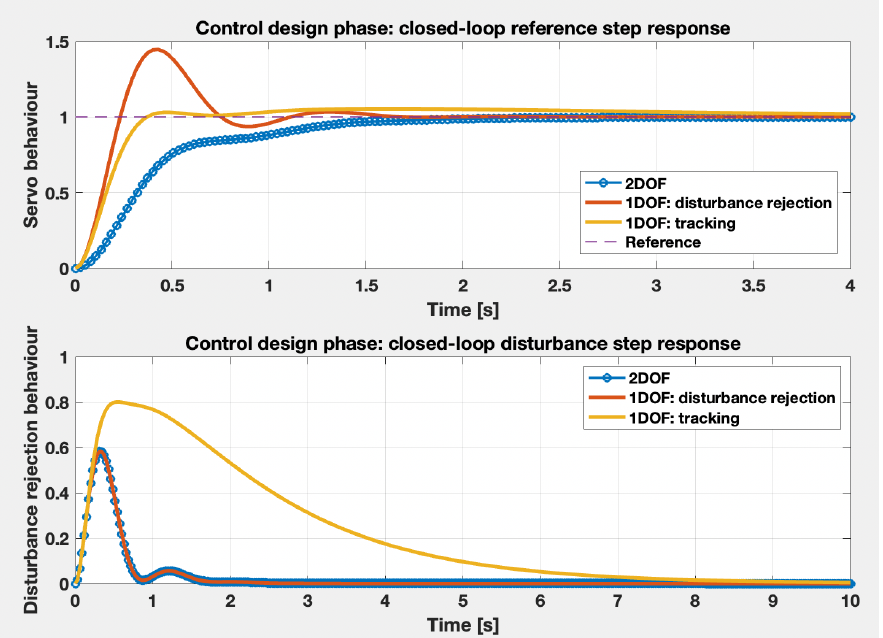
Figure 6. Closed-loop continuous-time domain simulations; step reference responses along with step disturbance rejections considering 1DOF regulators designed for servo tracking, disturbance rejection, and for performance in both cases,